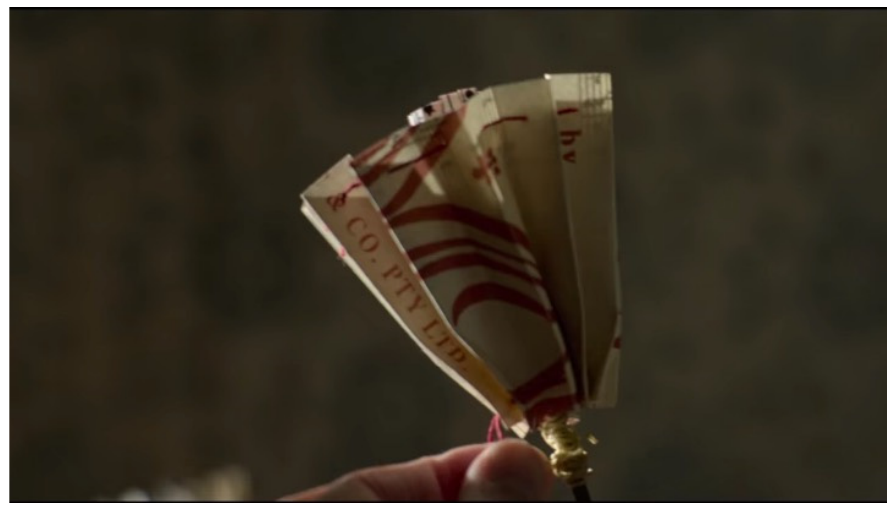
Figure 6. The Power of the Dog . Netflix.